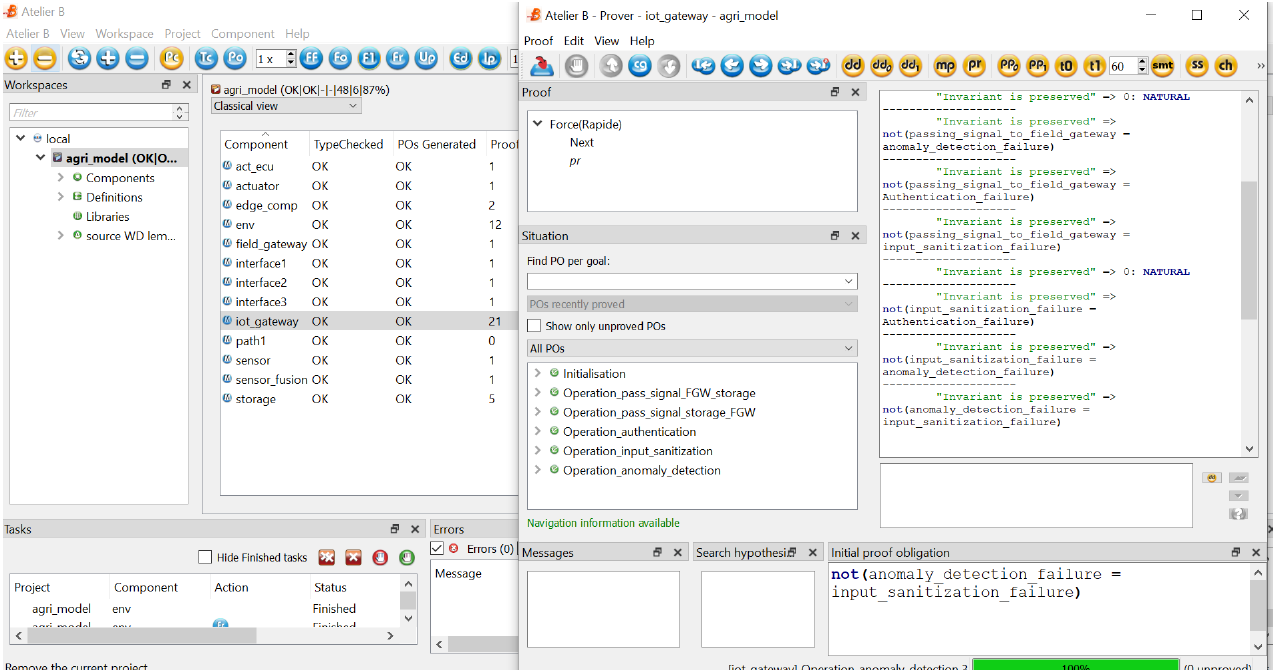
Figure 7. Proof obligations for the surface attack Path 1